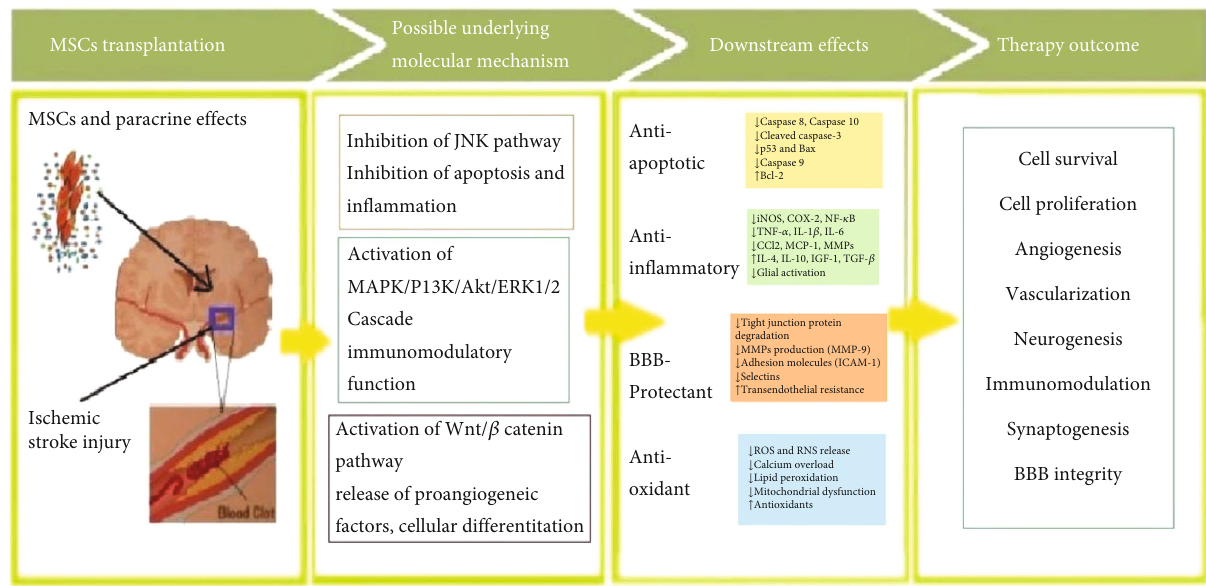
Figure 2: Schematic overview indicating the e ff ects of mesenchymal stem cell (MSC) based cell therapy in ischemic stroke recovery by demonstrating the underlying mechanism and downstream signaling